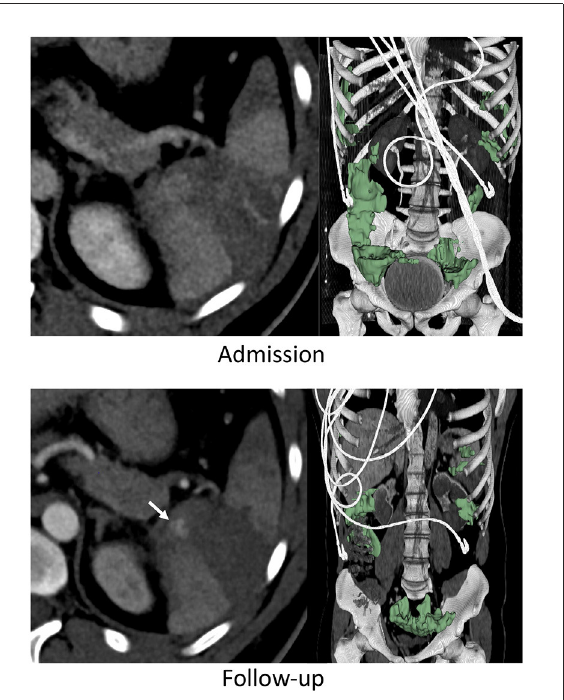
FIGURE2 Thirty three years-old male with BSI successfully managed non-operatively with adjunct AE. Admission CT shows an AAST grade 3 injury. A new pseudoaneurysm was seen on follow-up performed 25h later (arrow) but hemoperitoneum volume (green label mask) had decreased from to 262 to